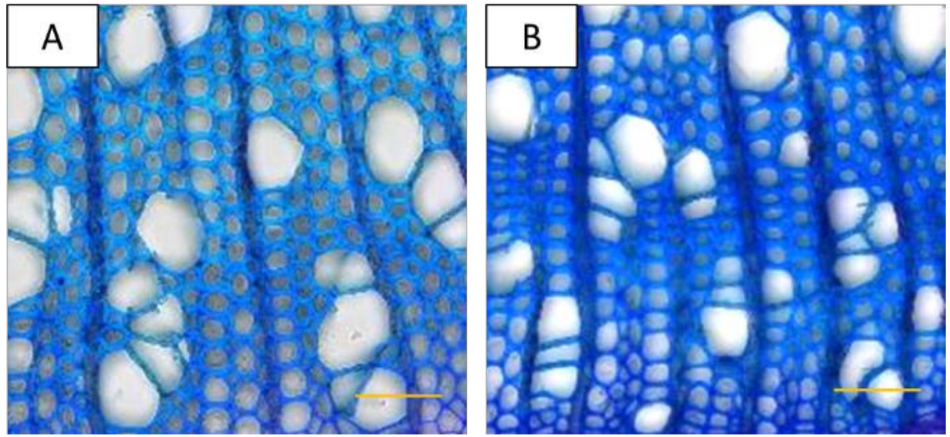
Figure 3. Cross sections of poplar (hybrid T89) wood from well-watered ( A ) and severely drought-